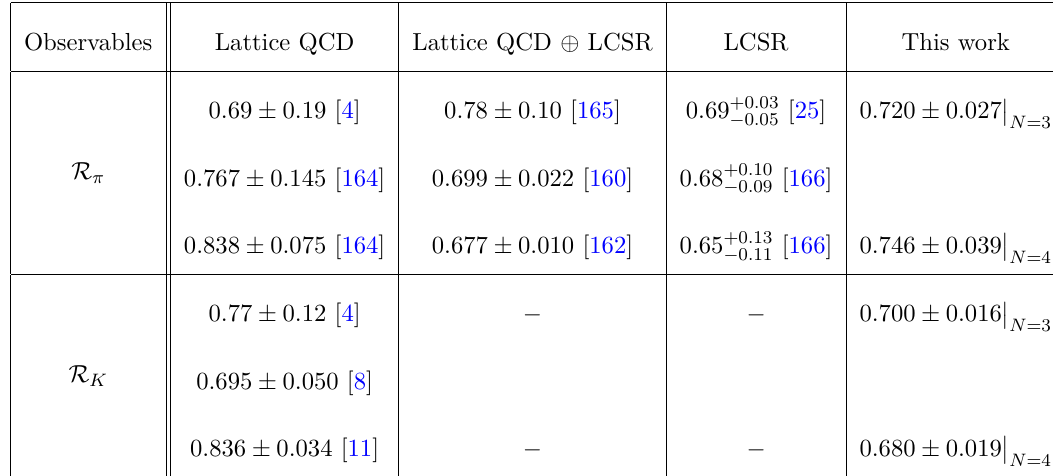
Table 7 . Theory predictions for the LFU ratios of the exclusive semileptonic B processes from the combined BCL expansion fitting against the synthetic lattice data points and the newly obtained LCSR